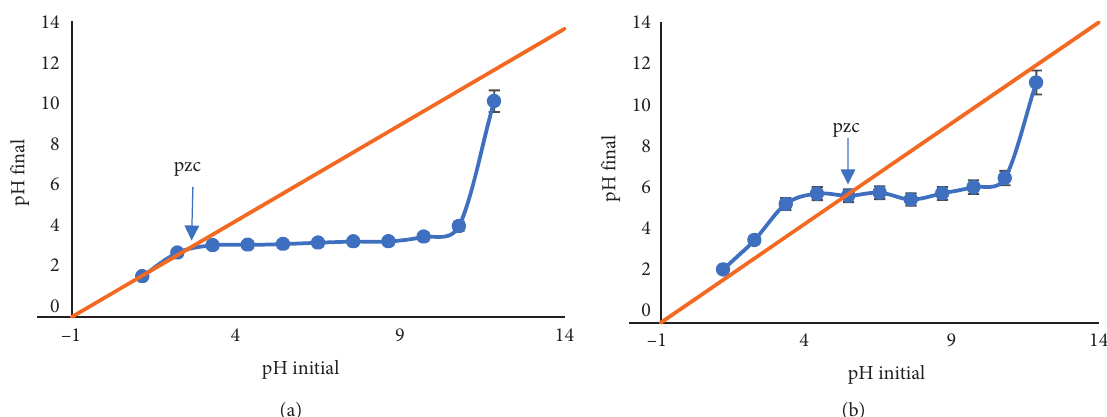
Figure 1: Point of zero charge (pzc) for peels (a) and seeds (b) of nance. pzc (pointed with the arrows) is found in the intersection of the 45 ° line with the experimental curve.